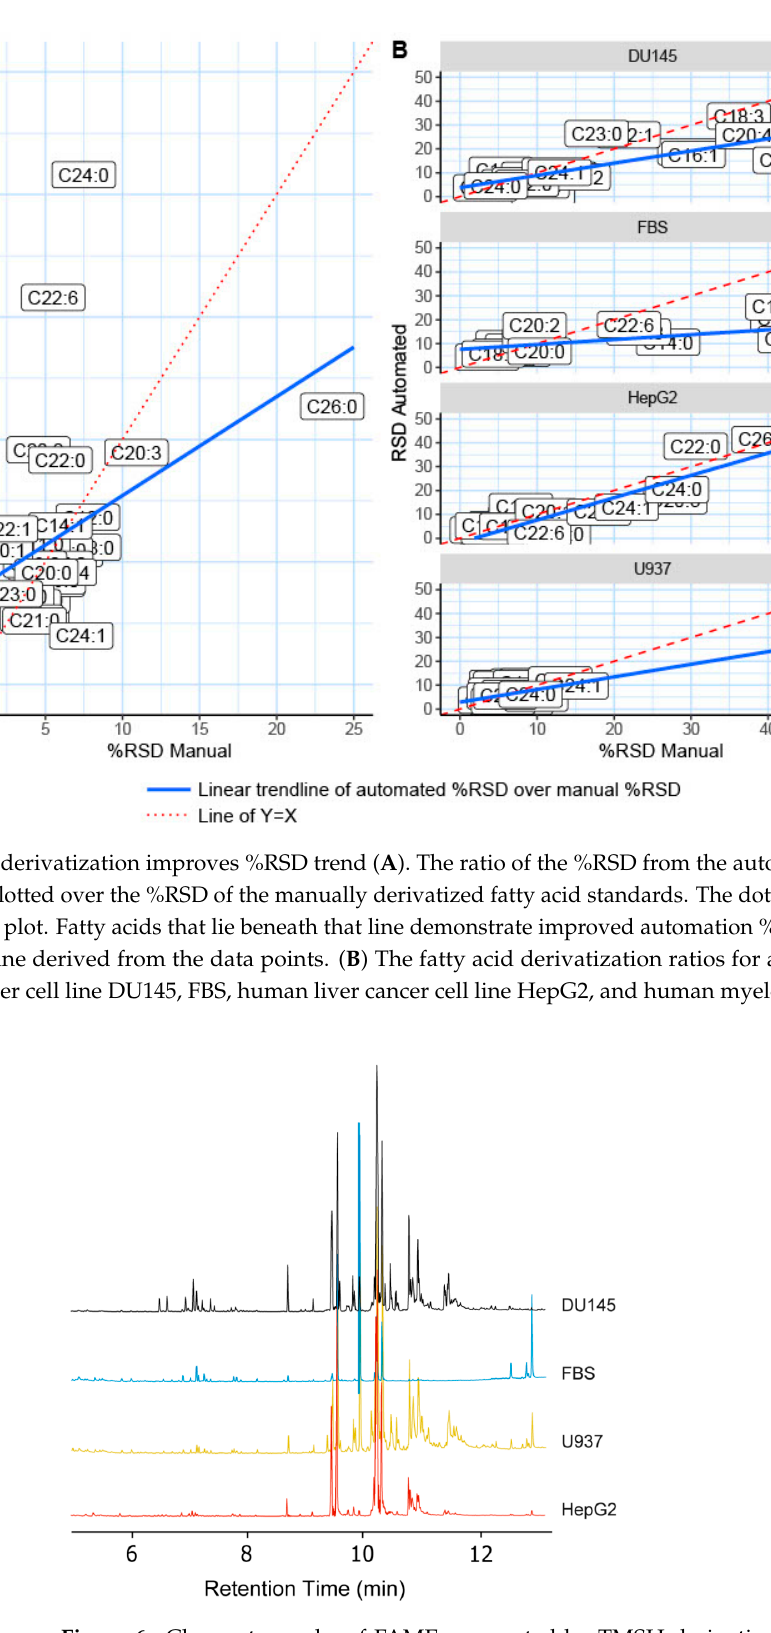
Figure 6. Chromatographs of FAMEs generated by TMSH derivatization. Representative chromatograms of biological matrices generated by TMSH derivatization, and the methods outlined in this paper.